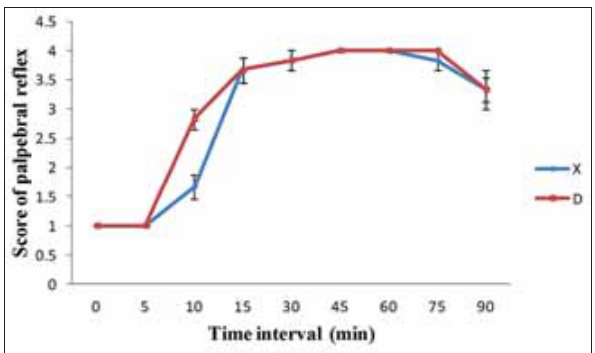
Figure-2: Mean±Standard error scores of palpebral reflex in animals of different groups. *Significantly different from the base value (p<0.05). **Significantly different from the base value (p<0.01).